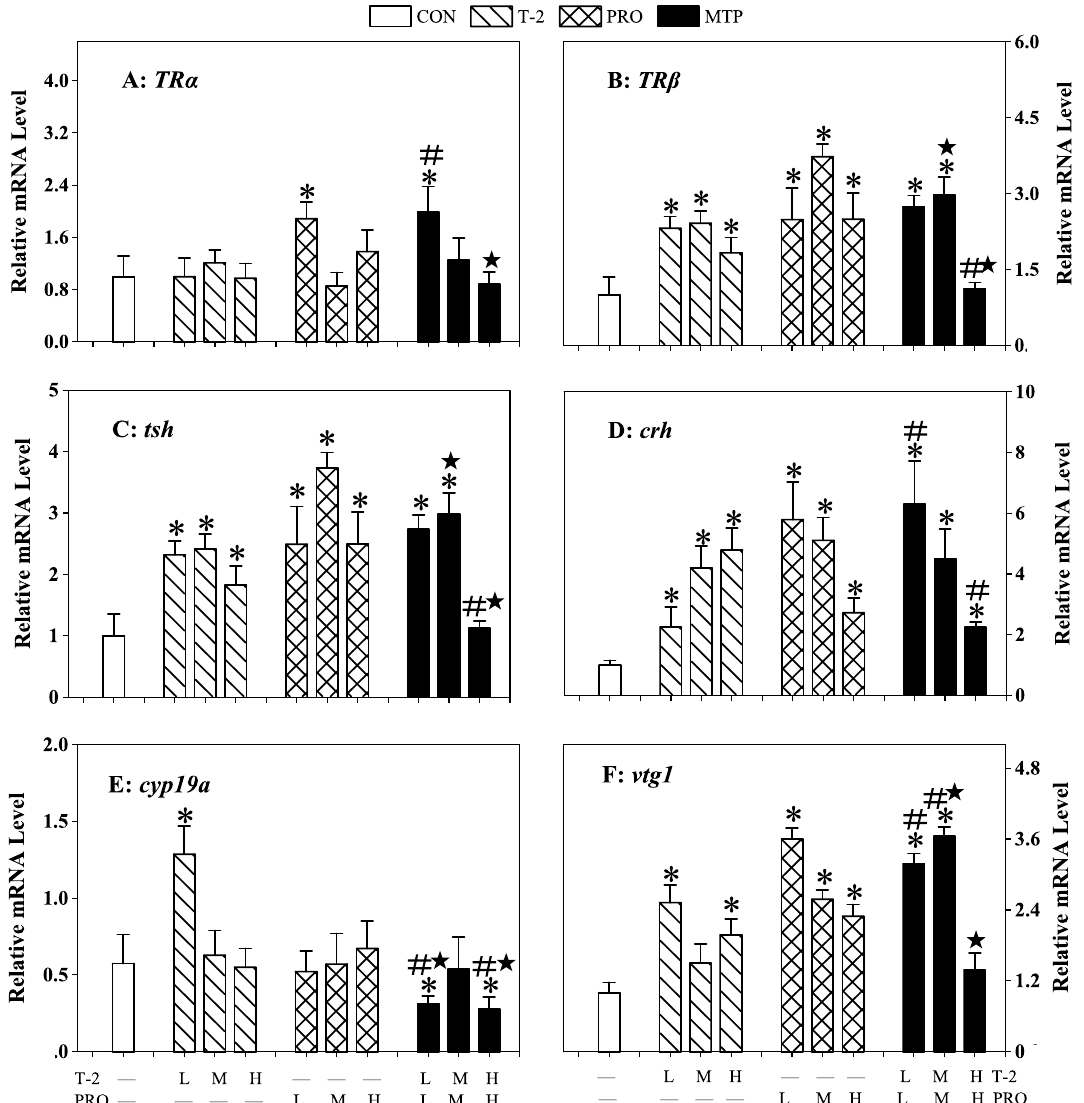
Fig. 6 Influences upon expressions of genes involved in the endocrine system in zebrafish treated with T-2 PRO and their combinations. A TRα , B TRβ , C tsh , D crh , E cyp19a , F vtg1 . Each bar represents the mean p < 0.05 substantial alteration by comparison with the control; # p < 0.05 significant difference relative to the corresponding T-2 exposure; ★ p <